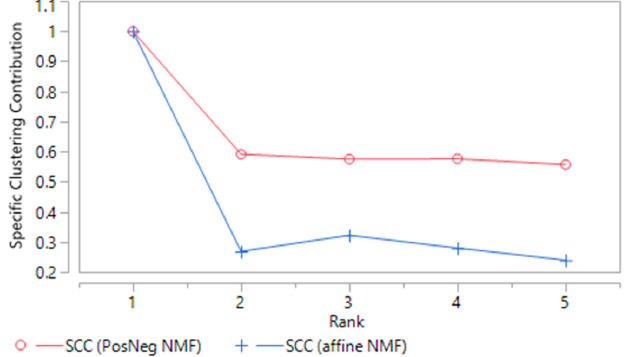
Figure 5. Specific clustering contribution of NMF clusters, PosNegNMF and affine NMF approaches.